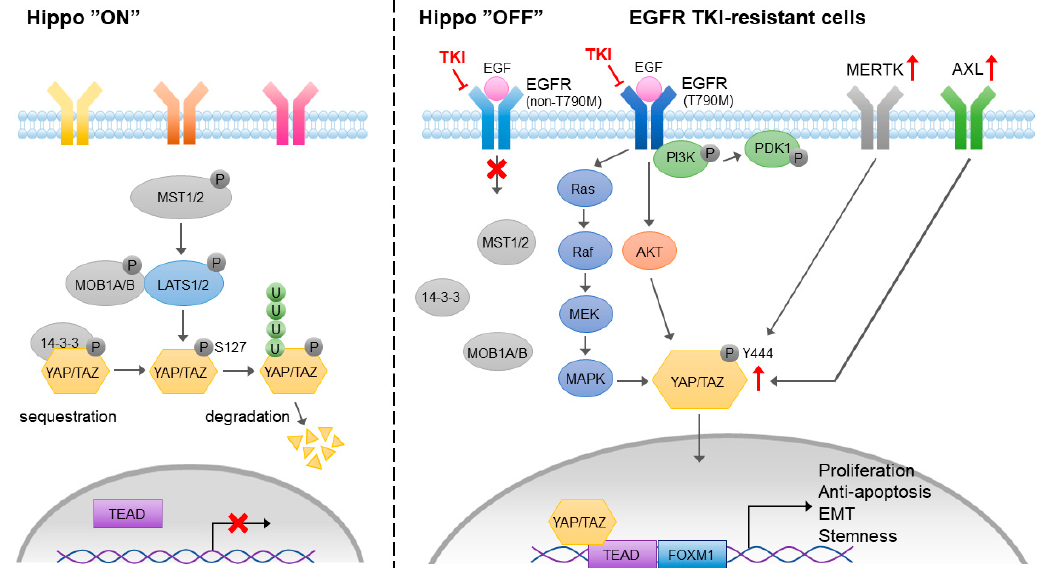
Figure 5. The role of MERTK in Yes-associated protein (YAP)-mediated EGFR-TKI resistance. Activation of hippo pathway blocks the nuclear translocation of YAP or promotes YAP degradation. In the EGFR-TKI resistant cancer cells, MERTK and Axl are upregulated. EGFR-mediated PI3K-independent Akt and MAPK signaling pathways contribute to the activation of YAP. In addition, MERTK may directly interact with YAP and phosphorylate YAP at Y 444 residue, which promotes its nuclear localization and transcriptional activity.